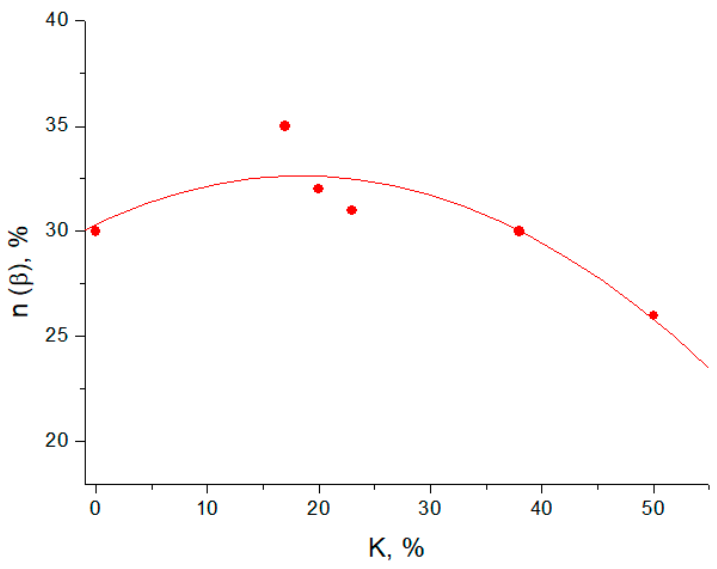
Figure 11. Change in the volume fraction of the beta phase depending on the degree of reduction in radial forging.